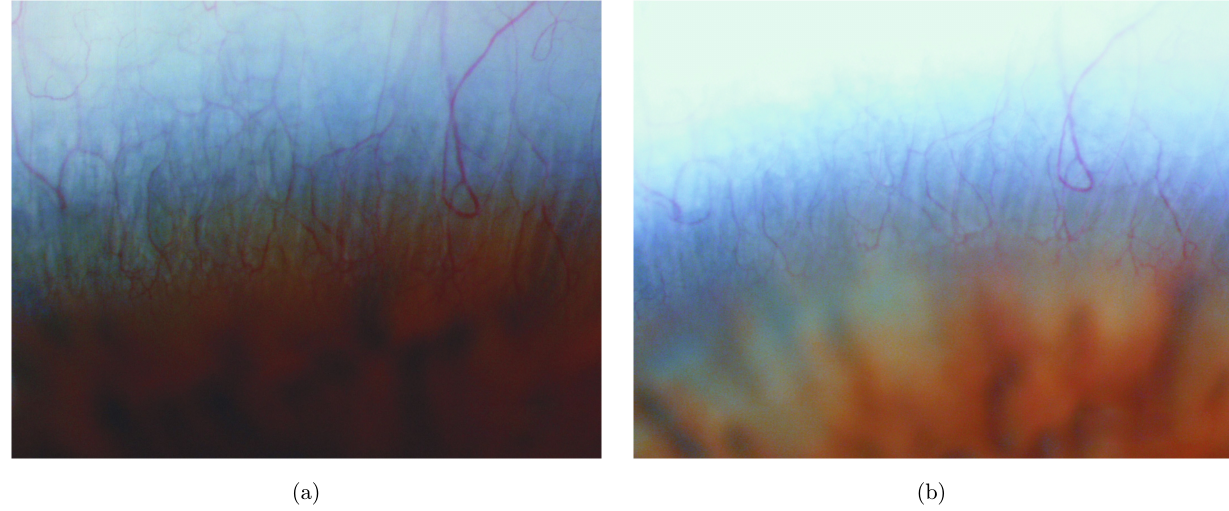
Fig. 1. Images at a higher magni¯cation (40 (cid:2) magni¯cation) of limbal hyperaemia in subjects from Group 1 before (1(a)) and 3 months after wearing lotra¯lcon B lenses